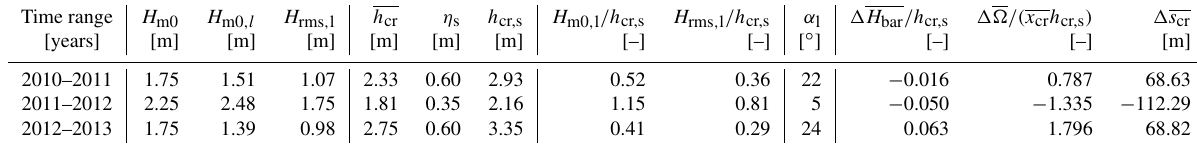
Table 3. Estimate of relative wave height, wave incidence and outer bar-geometry change for the examined time periods. Time